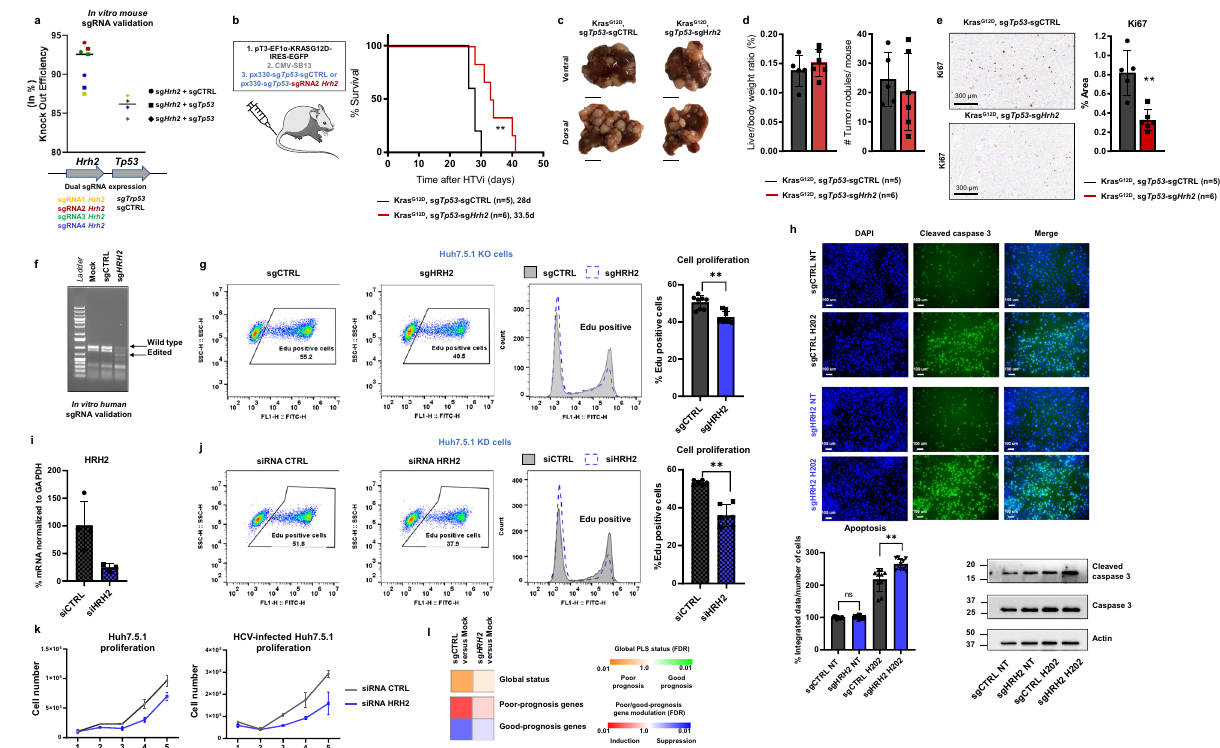
Fig. 5 Genetic loss-of-function studies con fi rm a functional role of HRH2 in hepatocarcinogenesis. a Validation of sgRNA targeting mouse Hrh2 and Tp53 . KO ef fi cacy was assessed by TIDE analysis. Plasmid constructs are described in method. b Hrh2 ( sg Hrh2) and Tp53 (sg Tp53 ) KO and Kras constitutive expression ( KRAS G12D ) or CTRLs were induced by injecting different plasmids constructs by HTVI in C57BL/6 males. Graph shows survival curves of injected mice. Median survival from injection to death is shown. Log-rank Matel – Cox test. ** p < 0.01. c Pictures of representative livers. Scale bars, 1 cm. d Liver weight body ratio and total number of tumor nodules per mouse are shown (mean ± SD; CTRL mice, n = 5; Hrh2 KO mice, n = 6). p > 0.05 (two- tailed Mann – Whitney U test). e Cell proliferation was assessed by the IHC evaluation of Ki-67 in liver tissues (mean ± SD; CTRL mice, n = 5; Hrh2 KO mice, n = 6). Scale bar, 300 µ M. ** p < 0.01 (two-tailed Mann – Whitney). f , g HRH2 KO decreases cancer cell proliferation in cell culture. f HRH2 KO validation at genetic level using T7 endonuclease assay. g Effect of HRH2 KO on cancer cell proliferation. EdU incorporation assay by FACS showing % ±SD of proliferative EdU-positive cell from three independent experiments in CTRL and HRH2 KO cells ( n = 8; ** p < 0.01, two-tailed Mann – Whitney U test). h Effect of HRH2 KO on cancer cell apoptosis induced by oxidative stress (H 2 0 2 ). Cleaved caspase 3 is shown in green. Nuclei were counterstained in blue (DAPI). Scale bar, 100 µ M. Graph shows integrated cleaved caspase 3 intensity/total cell number from two independent experiments ( n = 12; ** p < 0.01, two-tailed Mann – Whitney U test) measured using Celigo Cytometer. Western blot analysis of cleaved- and total caspase 3 is shown. i – k Effect of HRH2 knockdown on cancer cell proliferation. i siRNA ef fi cacy was assessed by measuring mRNA by qRT-PCR. j EdU incorporation assay by FACS showing % ±SD of proliferative EdU-positive cell from three independent experiments in cell transfected with siCTRL and siHRH2 ( n = 6; ** p < 0.01,